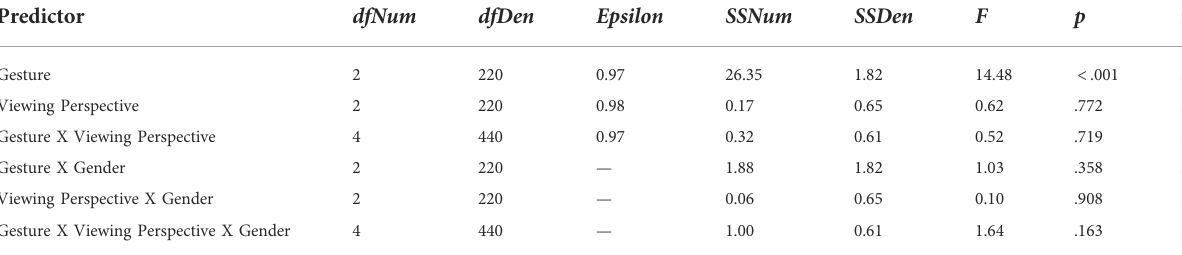
TABLE 7 Results of the mixed-measures ANOVA for the perceived cooperativity of the robot. Predictor